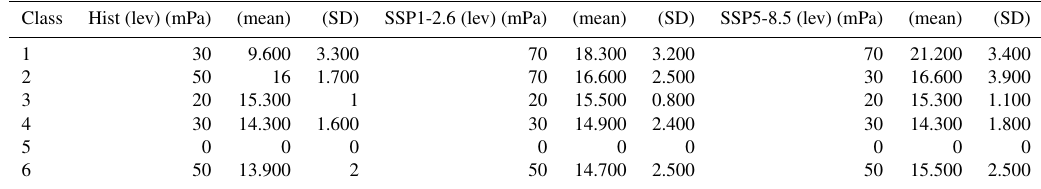
Table D4. The same as Table D1 but for SON.